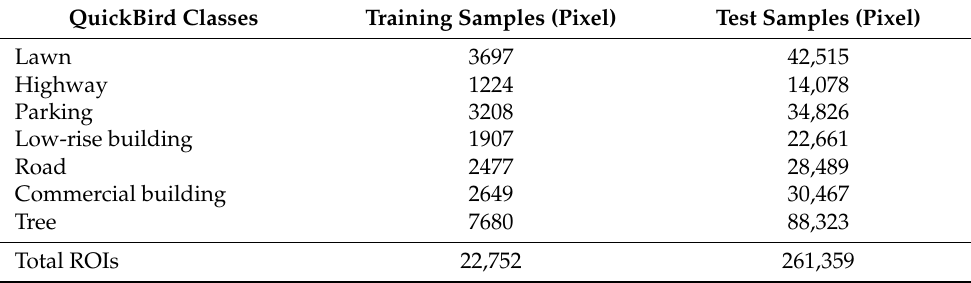
Table A3. Training and test samples for each class in the Denver image.